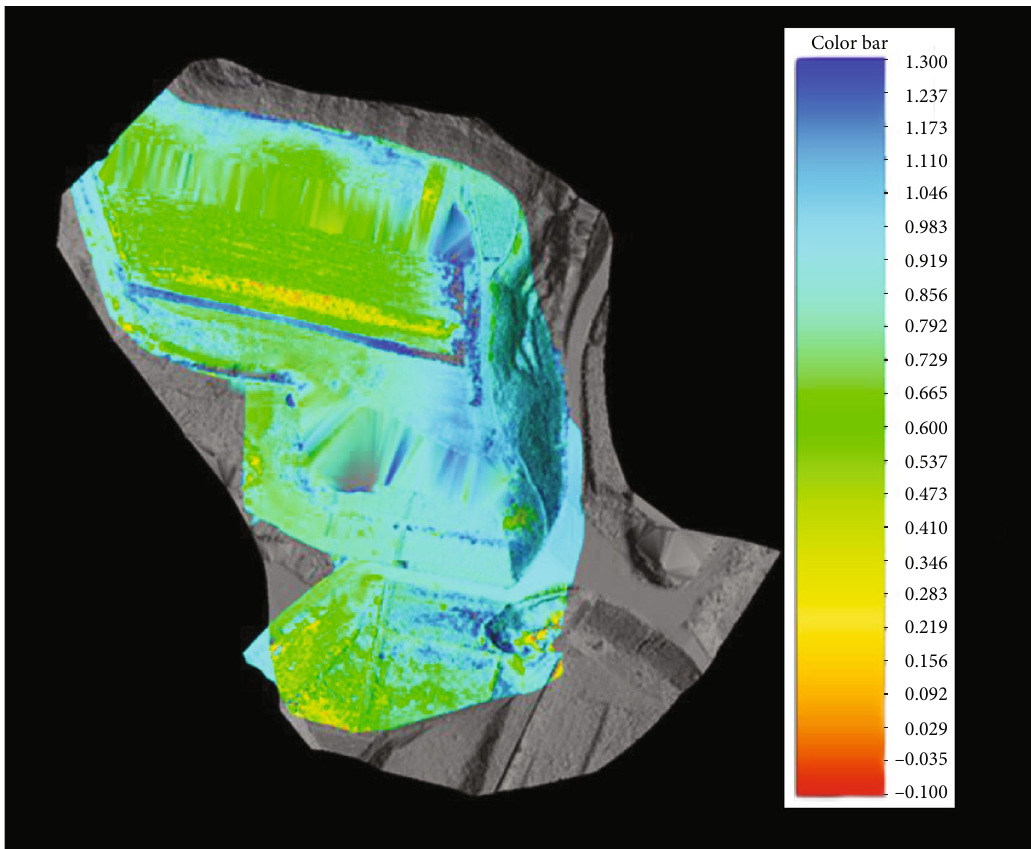
Figure 12: Comparison of point cloud DEM in the third and third